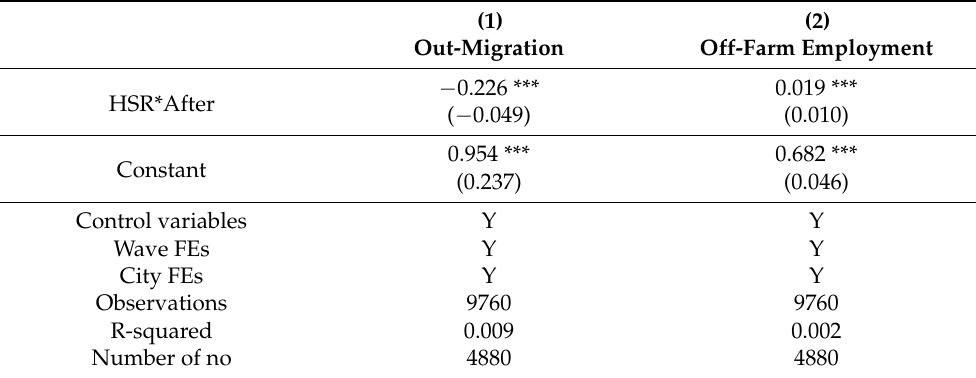
Table 7. Mechanism analysis: impact of the HSR on rural labor force out-migration and off- farm employment.